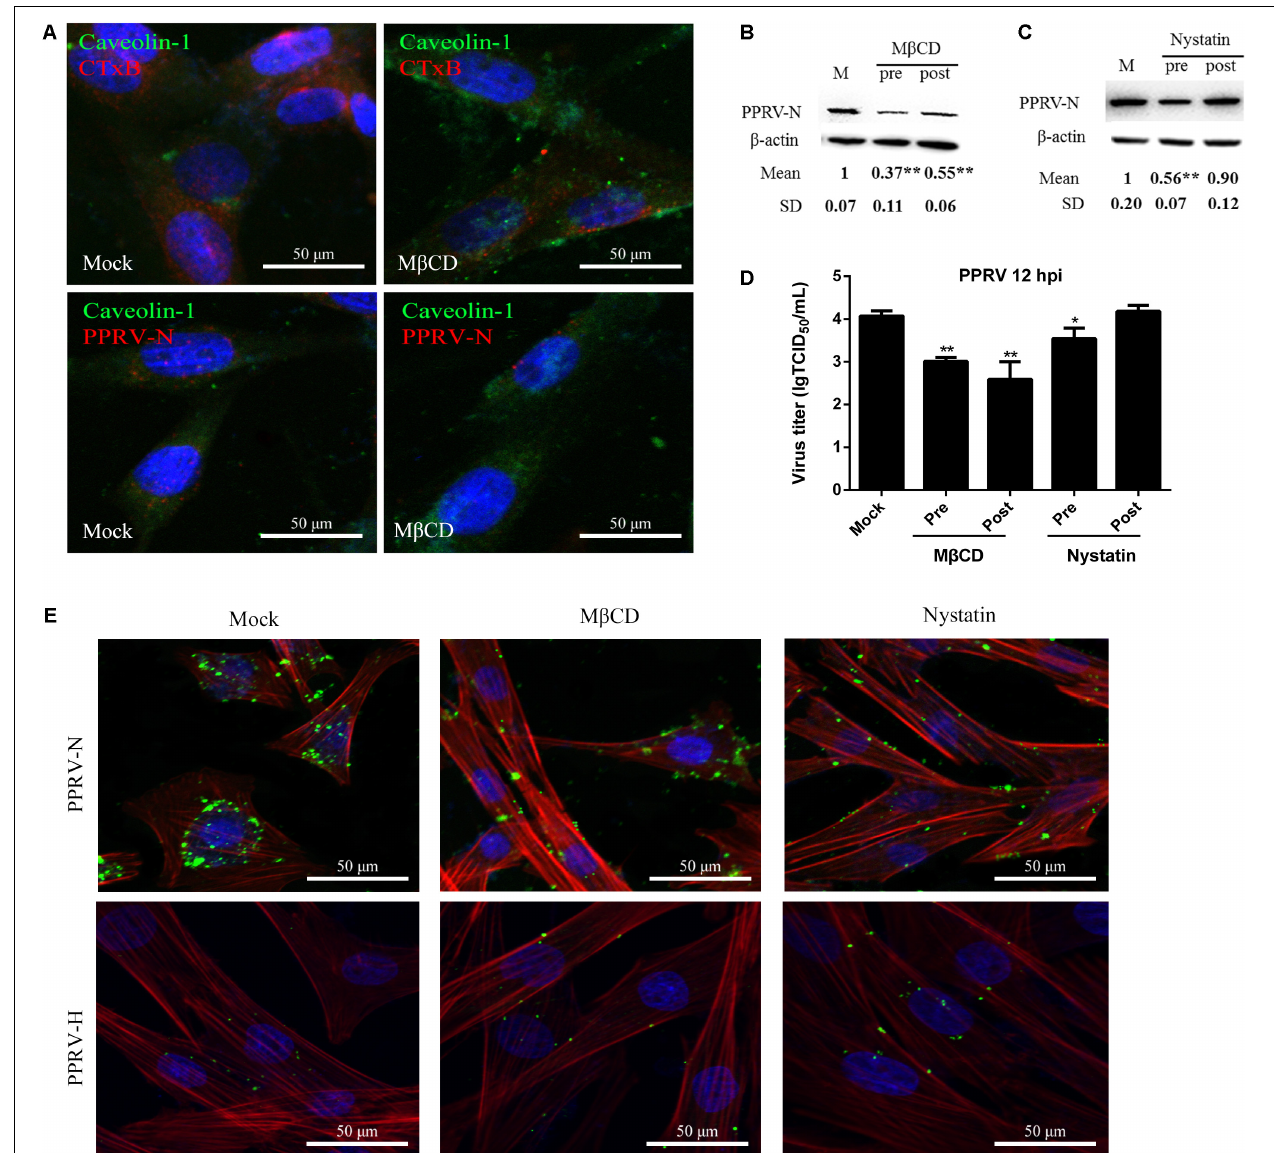
FIGURE 5 | Peste des petits ruminants virus entry and replication in EECs requires plasma membrane cholesterol. (A) CLSM analysis of caveolin-1 (green), viral particles (red) and cell nuclei (blue) in PPRV-infected EECs pre-treated with M β CD. The effect of M β CD on Alexa Fluor 594–CTxB uptake was apparent (red). (B,C) Western blot analysis of the entry of PPRV in mock-, M β CD- or nystatin-treated cells. β -actin was used as an internal control. (D) Virus titration analysis of PPRV treated with M β CD and nystatin. (E) CLSM analysis of TRITC-phalloidin (red), anti-PPRV (green) and DAPI (blue) in PPRV-infected EECs pre-treated with M β CD and nystatin. The bars indicate the mean ± SD from three independent experiments. SD, standard deviation; ∗ P < 0.05; ∗∗ P <